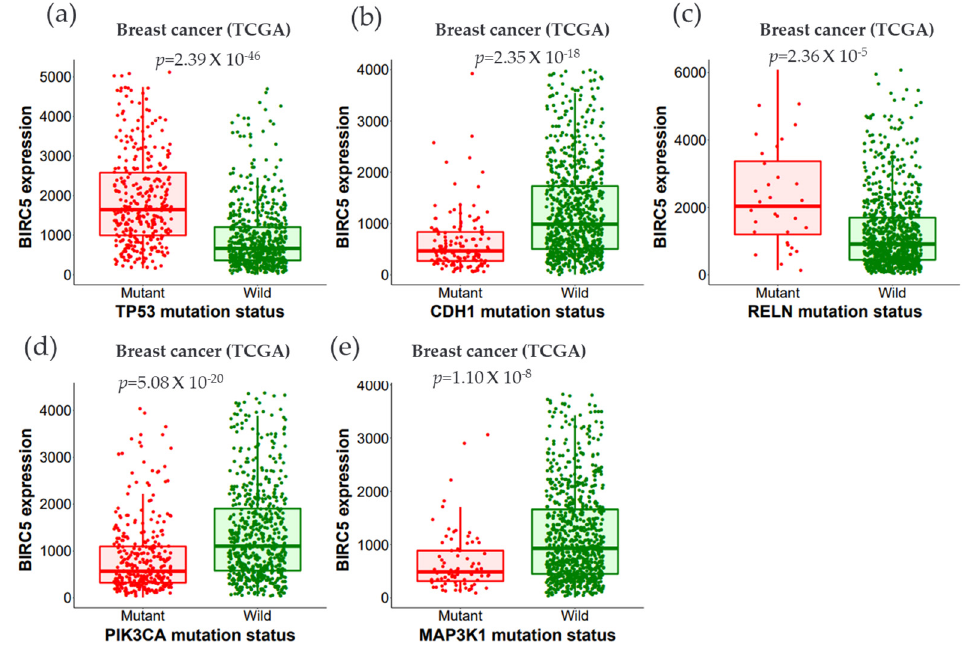
Figure 9. The relationship between BIRC5 expression and essential gene mutations. ( a – e ) show the expression of BIRC5 with the mutation status of the most frequently changed genes ( TP53, CDH1, RELN, PIK3CA, and MAP3K1 ). Violin plots were generated using TIMER2.0